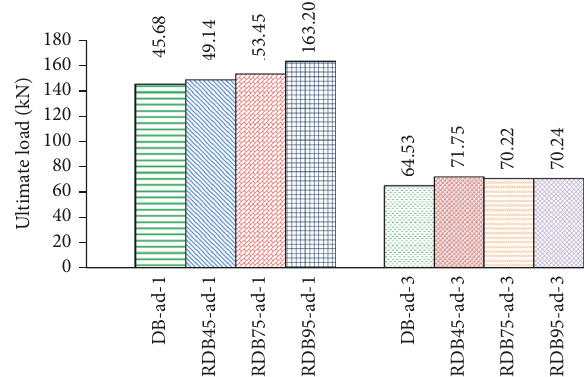
Figure 12: Ultimate loads of shear-designed beams tested at a / d ratios 1 and 3.